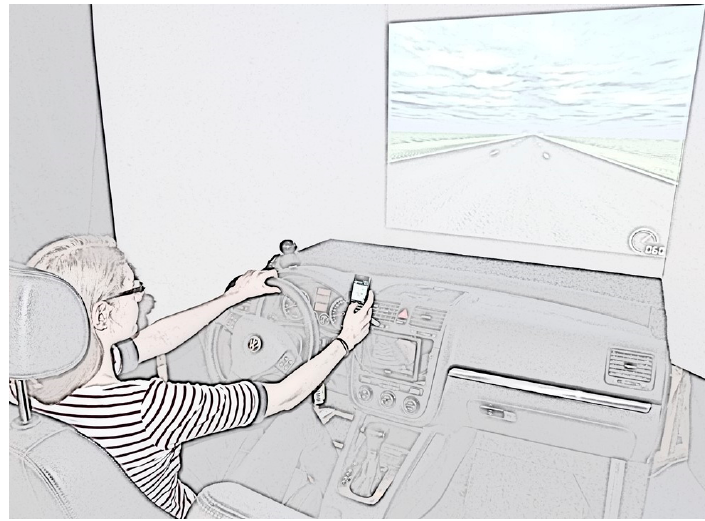
Figure 1. Sketch of the experimental setup.